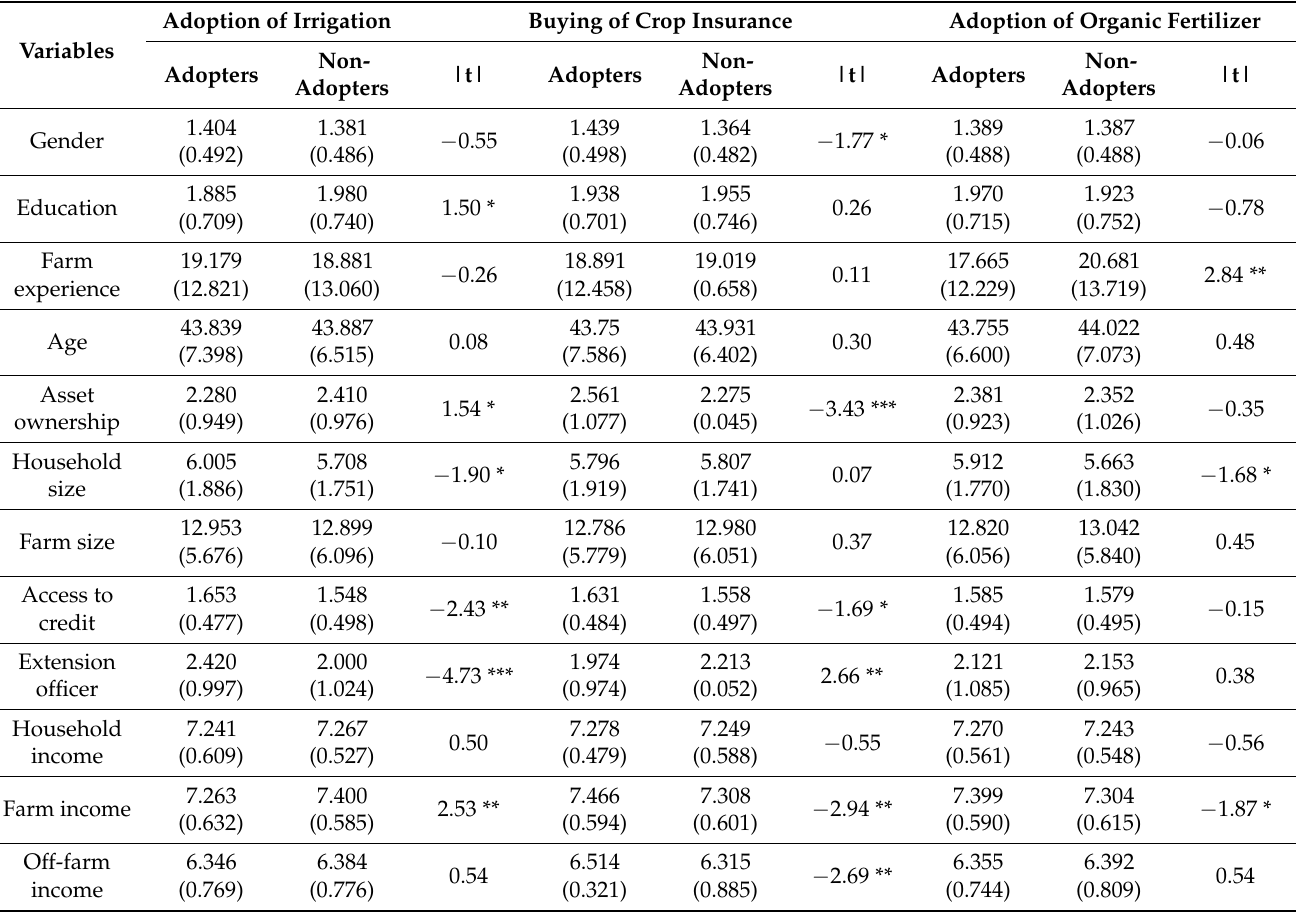
Table 4. Mean differences between adopters and non-adopters of climate-smart agricultural